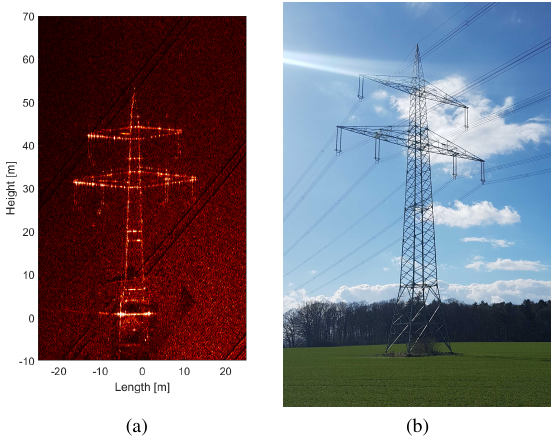
Figure 11. CSAR target imaging. (a) Estimating object’s height from vertical plane (b) Photograph of